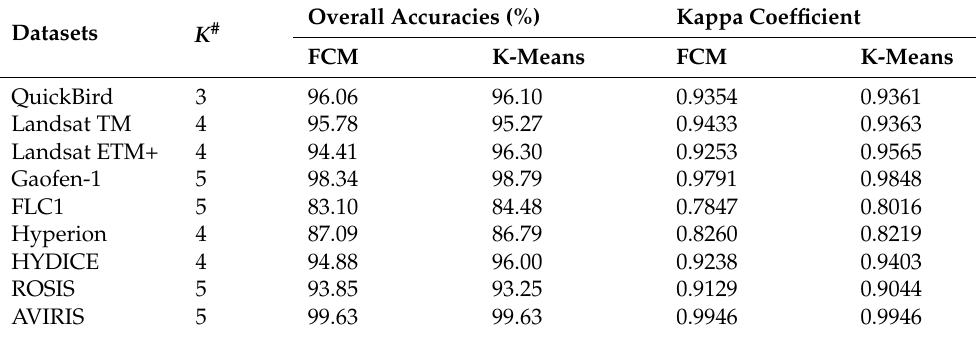
Classification accuracies of the remote sensing images acquired by FCM and K-means algorithms.